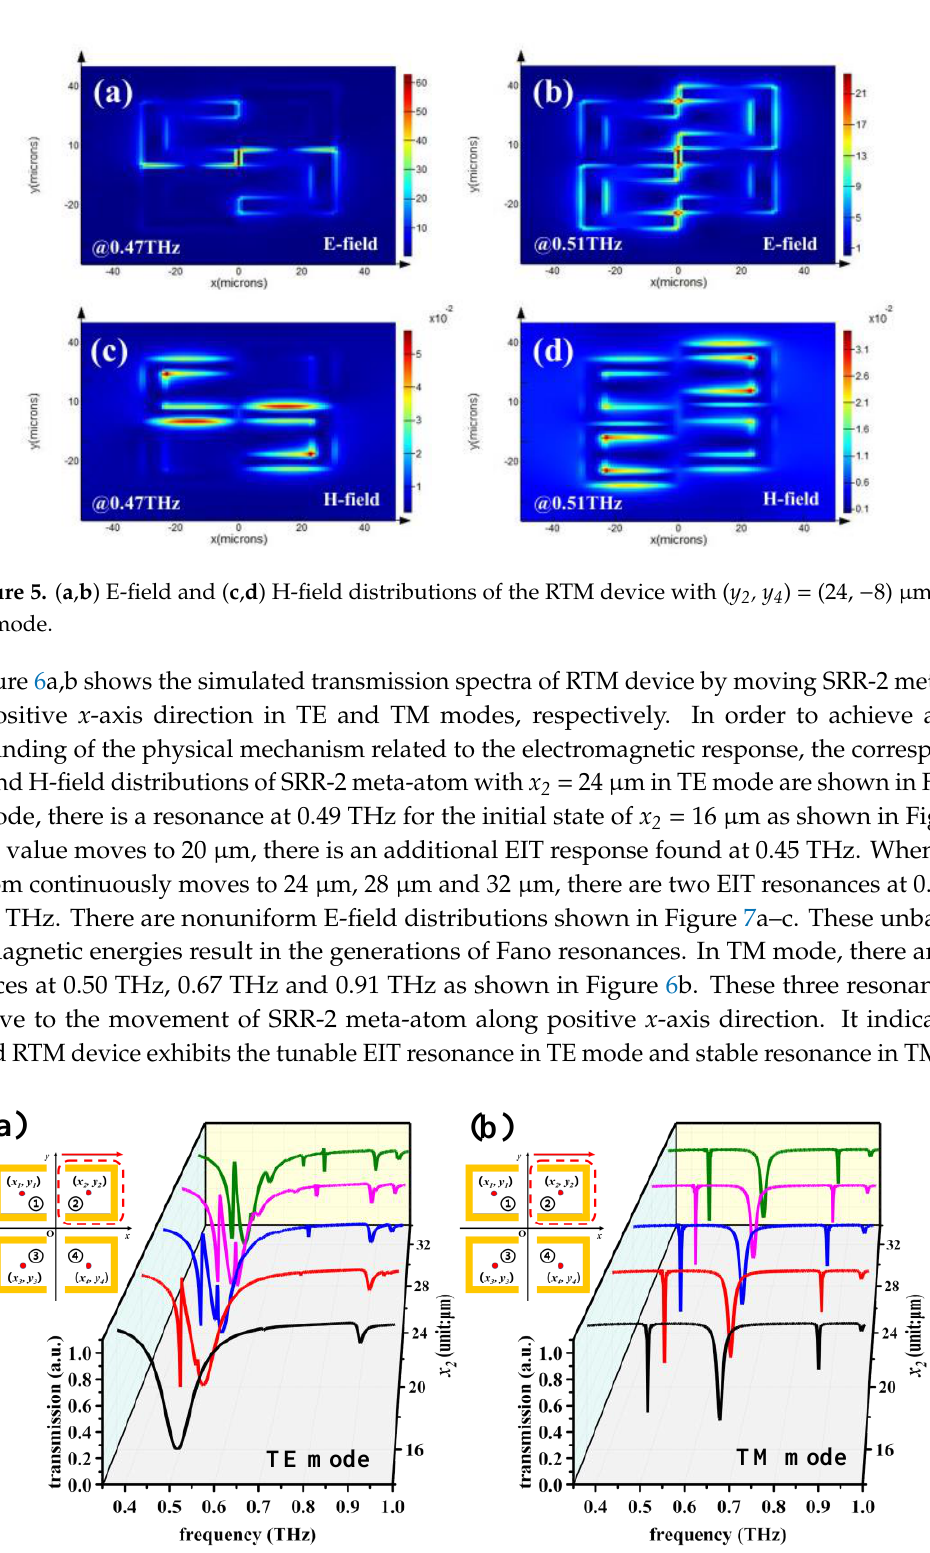
Figure 6. Simulated transmission spectra of the RTM device obtained by moving the SRR-2 meta-atom along positive x -axis direction in ( a ) TE and ( b ) TM modes.